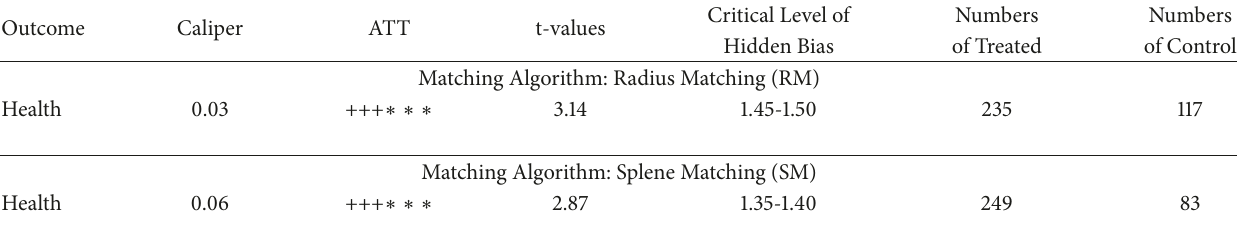
Table 8: Consumers perception regarding impact of functional food on human health (PSM